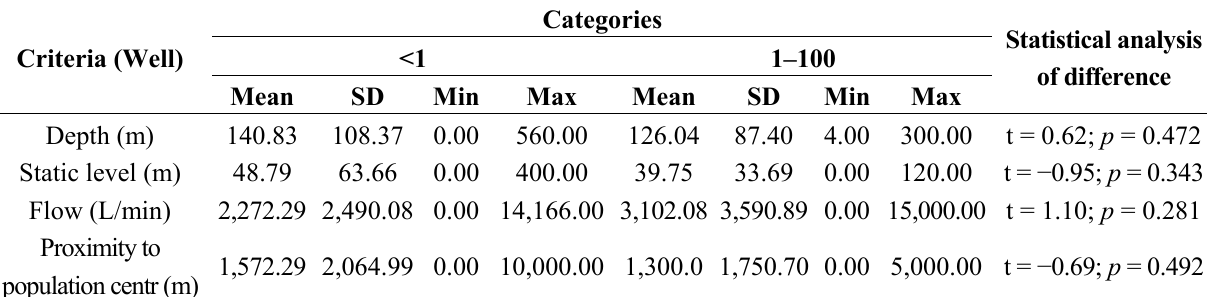
Table 3. Profile characteristics